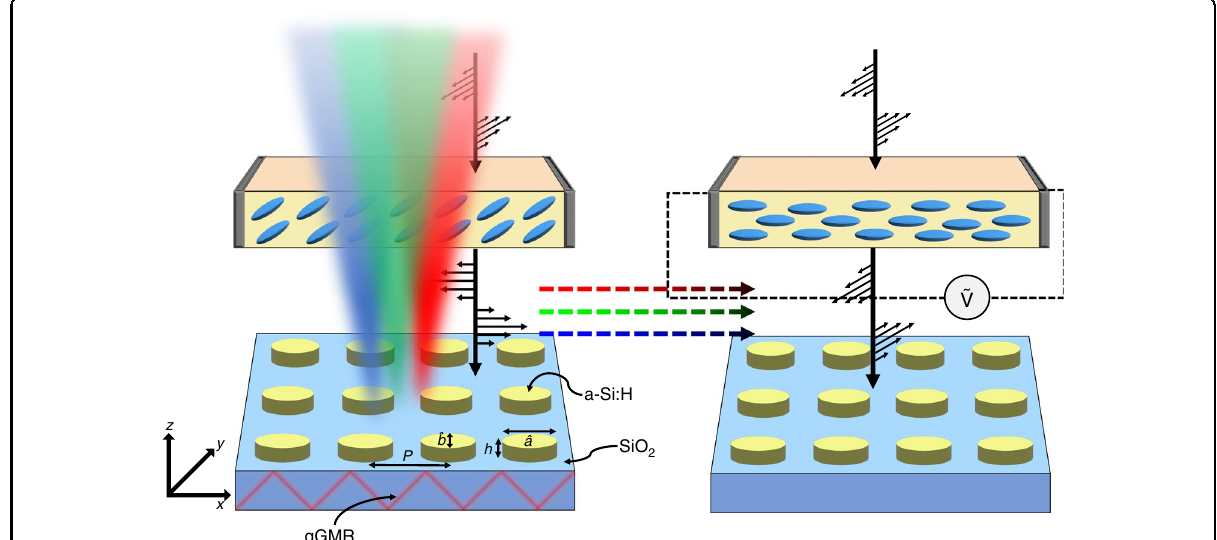
Fig. 1 Elliptical meta-atoms combined with LCs for electrically tunable structural color. Schematic of the elliptical meta-atoms combined with an LC cell for electrically tunable color, and its working mechanism through the enhancement of Mie scattering through the quasi-guided mode resonances (qGMR) induced from the lattice. Electrical tuning of the incident polarization of light via an input bias ( Ṽ ) on the LC cell allows for the continuous tuning of the scattering power of the meta-atoms, which manifests a modulation in the color production from bright vivid colors to dark